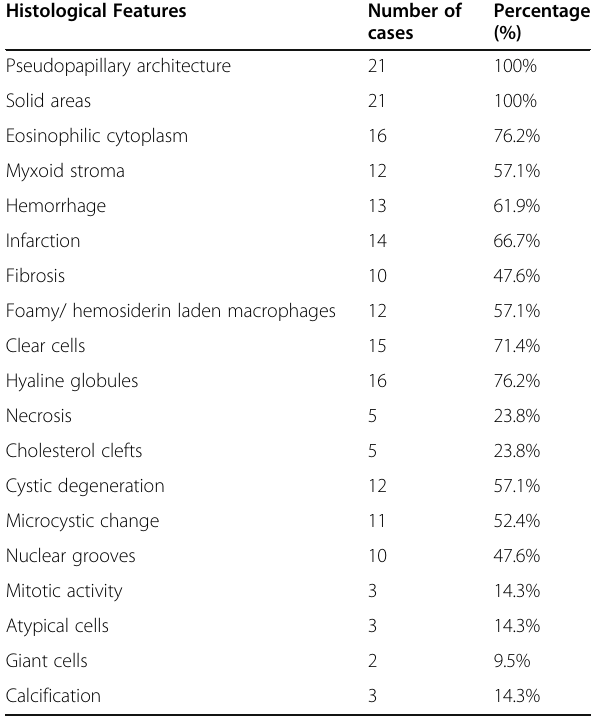
Table 1 Histological features of SPNs in patients above 20